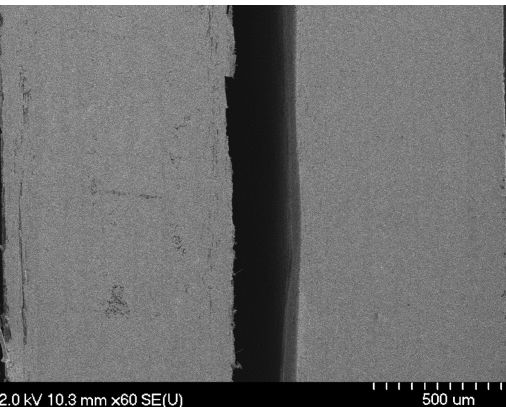
Figure 13: Comparison between autoclave-treated sample (right photo) and non-autoclave-treated sample (left photo) taken from truncated cone #